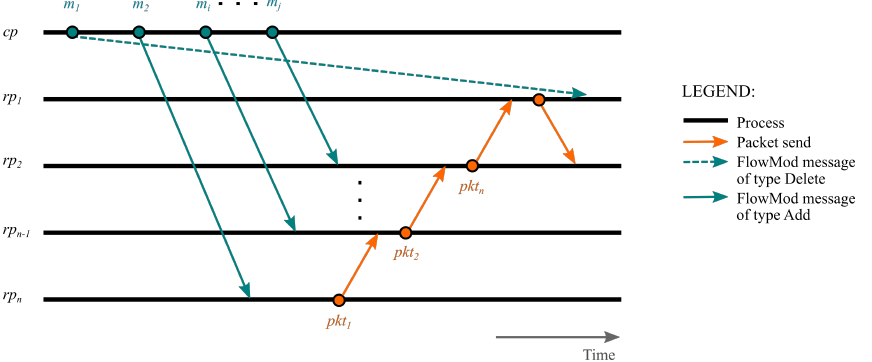
Figure 5. The communication diagram corresponding to Figure